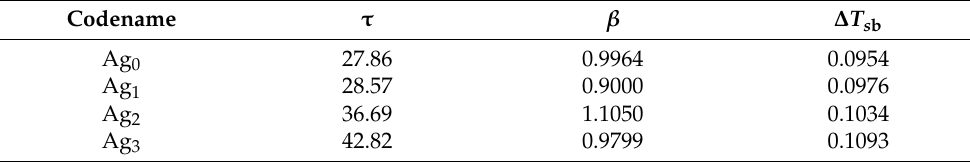
Table 2. Fitting parameters obtained from Equation (2) that correspond to the